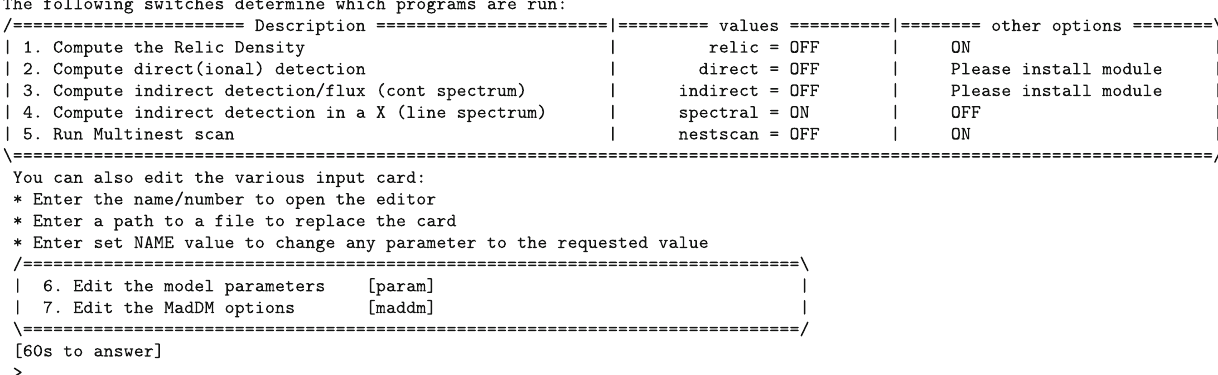
Fig. 4 Exampleofthelaunchinterfaceafterperformingthe launch commandin MadDM ingamma-raylinecomputations.Theindirectdetection spectralfeaturecalculationsareturnedon,whilerelicdensity,directdetection,continuumindirectdetectionandthescancapabilitywith MultiNest are switched